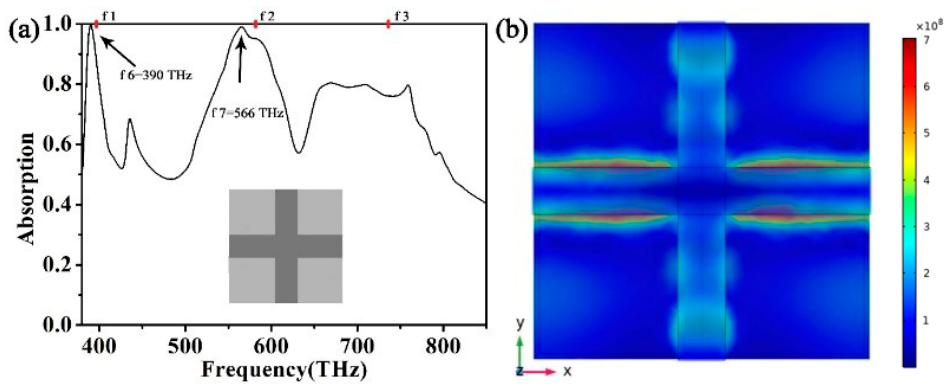
Figure 9. ( a ) Absorption spectrum of the absorber in the presence of a magnetic field with only the cross structure. ( b ) The electric field diagram of the absorber at f6.